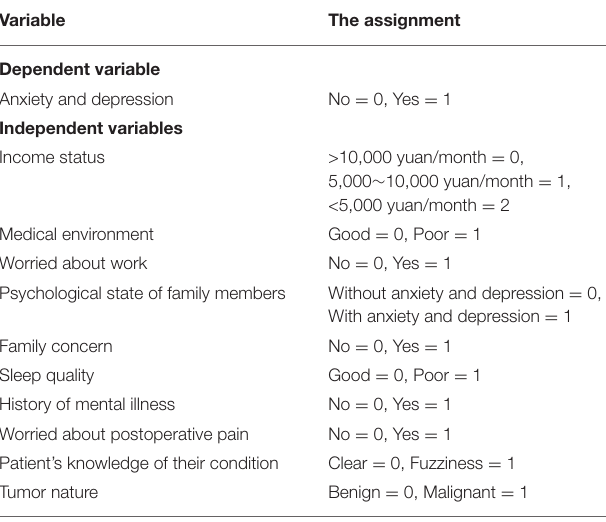
TABLE 2 | Variable assignment table of multi-factor analysis of depression and anxiety of patients with pulmonary tumor during perioperative period. Variable